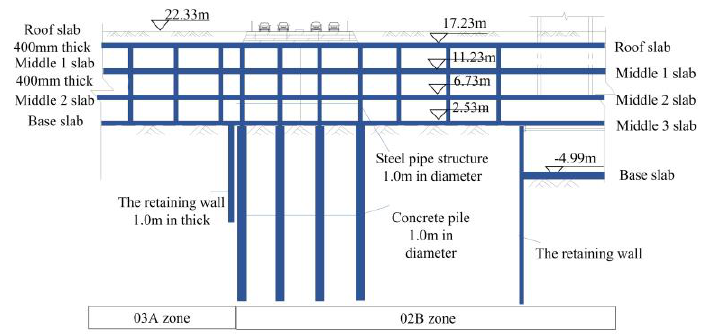
Figure 2. Cross − section 1−1 of 02B zone and 03A zone.